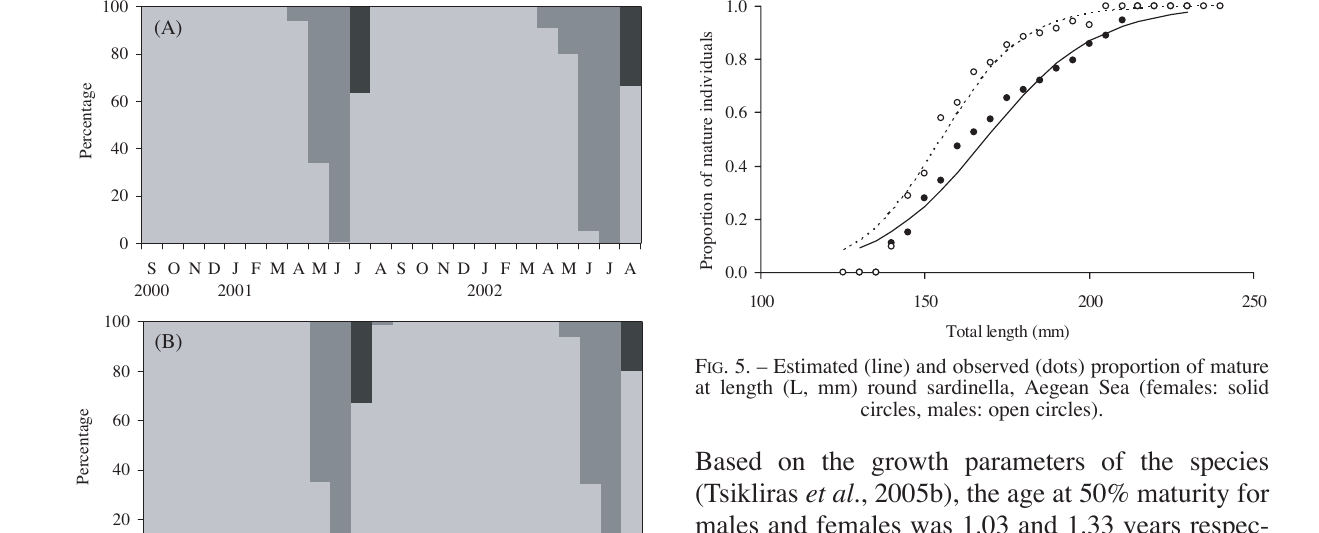
, mm) and age (t , yr) at 50 50